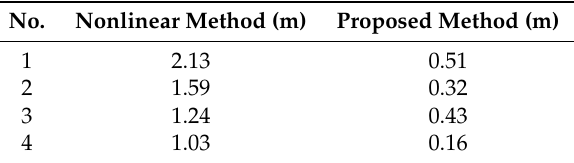
Table 2. Errors of step length estimation.